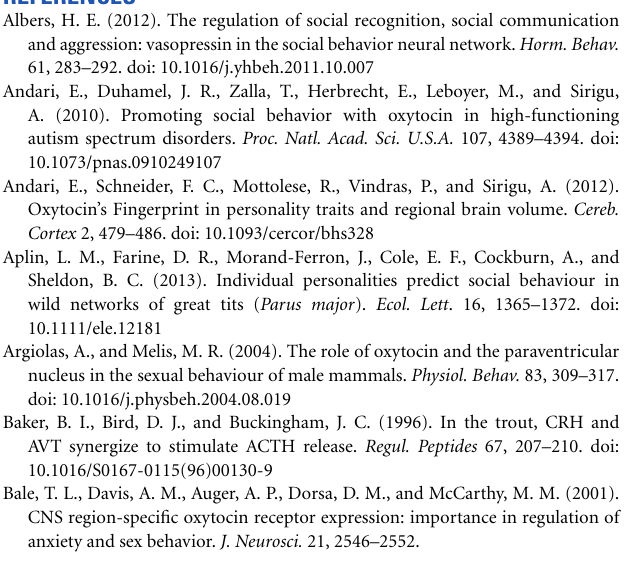
Supplemental Table 1 | Principal components matrix of male zebra finch behavior. Supplemental Table 2 | Principal components matrix of female zebra finch